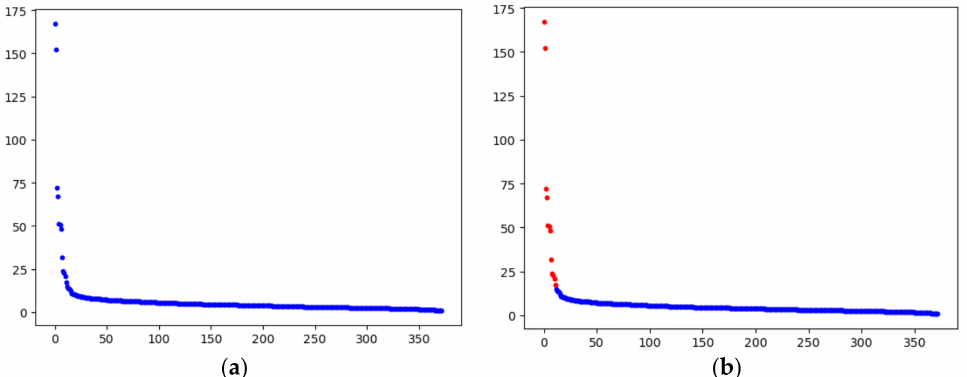
Figure 8. Calculate and select key points: ( a ) the distribution of product results; ( b ) key points’ selection result.